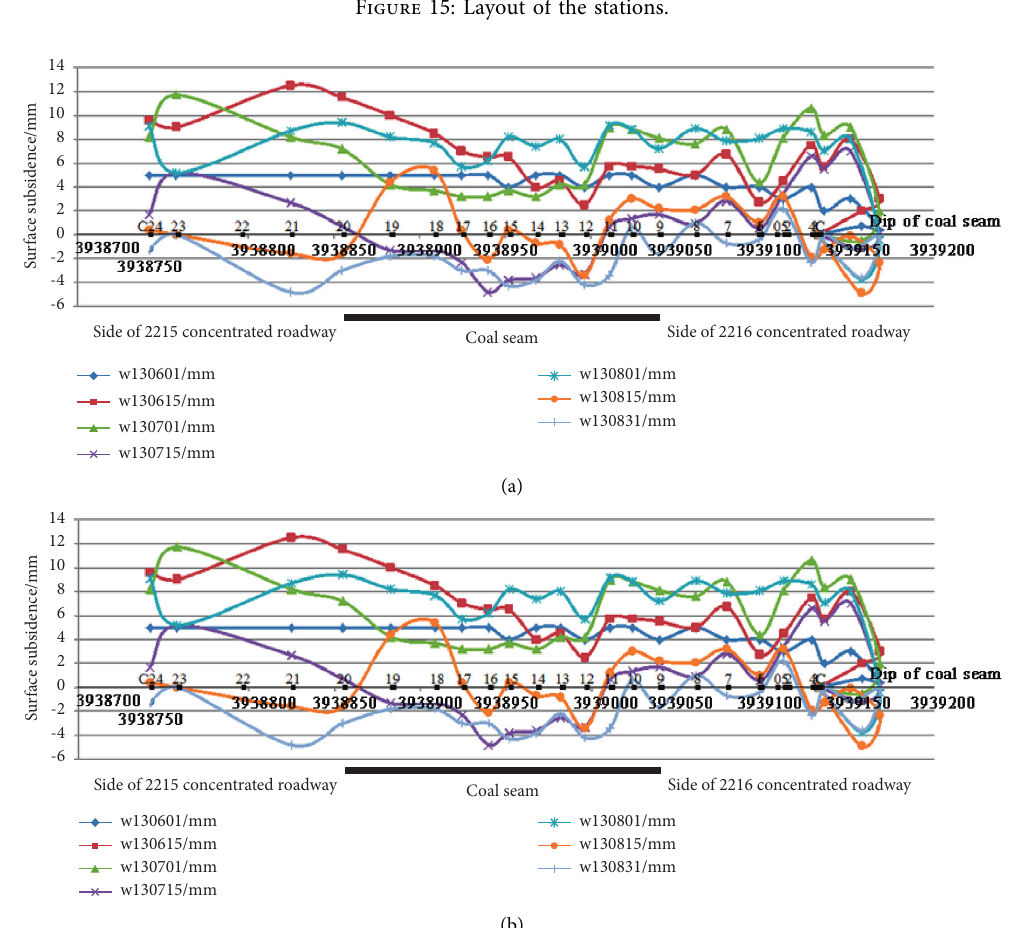
Figure 16: Monitoring curves of (a) the strike survey line and (b) the trend line.